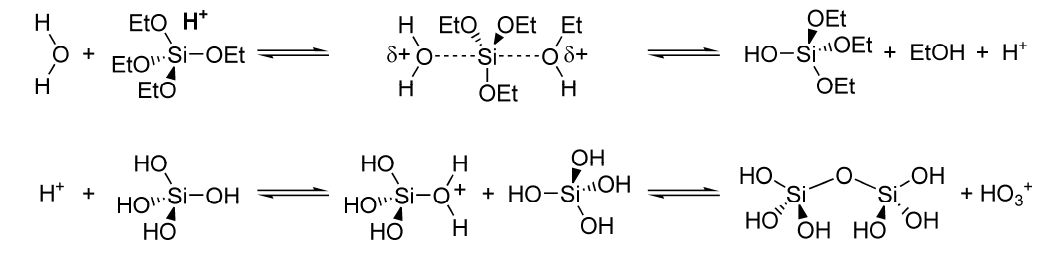
Figure 13. Mechanism of the sol–gel reaction. Figure 12. Synthesis of the PEDOT:PSS/silica composite using sol–gel reaction.